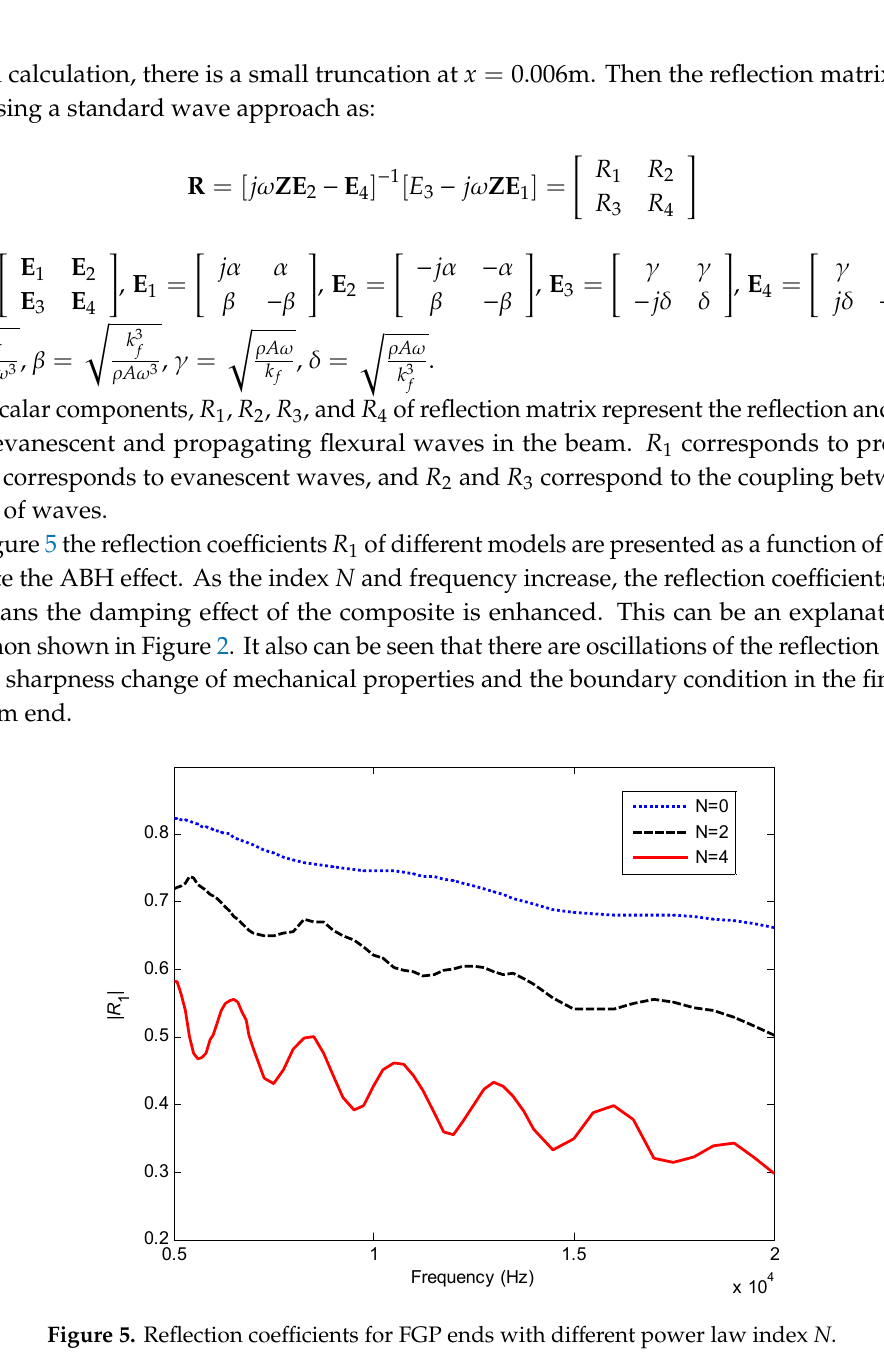
Figure 6. Scalar impedance Z 1 along x -axis. 3.2. 2D Plate Centred with FGP Disk For 2D application, a rectangle cantilever plate with dimensions of 0.3 × 0.15 × 0.0015 m is show in Figure 7. A central symmetry FGP disk with power-law porosity along the radius locates at the central of the plate. The symmetry plane of the FGP disk is same as the previous 1-D case with N = 6. The material properties are shown in Table 1. Frequency and transient analysis is investigated by